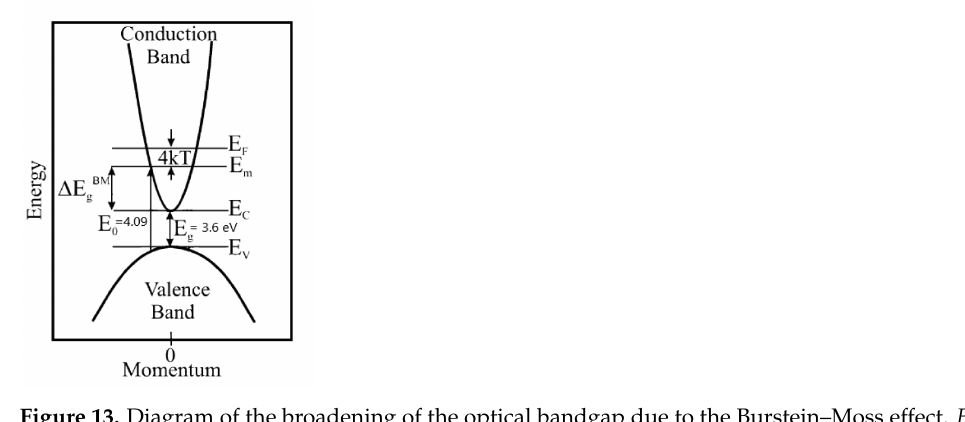
Figure 13. Diagram of the broadening of the optical bandgap due to the Burstein–Moss effect. E g is the fundamental band gap and E 0 is the optical